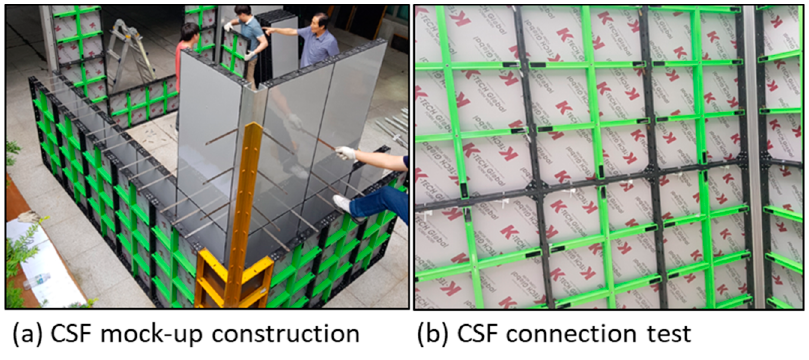
Figure 9. A mock-up assembly house made up of CSF (( a ) constructability test, ( b ) connectivity test).